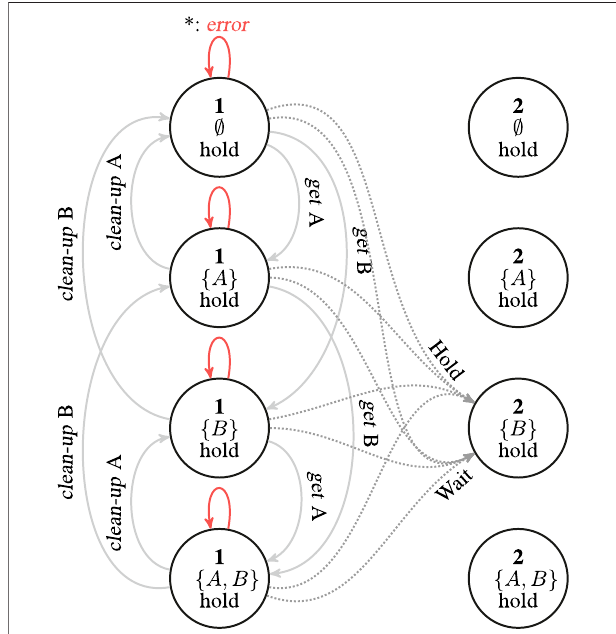
FIGURE 2 | Simpli fi ed representation of the restricted model (RM) used in this work. The fi gure represents an RM associated with a subtask 1 whose successorintheHTMissubtask 2 .Thiscouldbeanyoftheterminatingnodes in Figure 1 that are connected via a sequential operator; please refer to Section 3.3 to understand how to connect RMs with the alternative and parallel operators).Forthesakeofsimplicity,the fi gureonlyrepresentsactions that are taken starting from subtask 1 . We assume that only two objects “ A ” and “ B ” are available and that “ A ” is consumed by the subtask (like a part of the assembly would be) while “ B ” is a tool used during the task (e.g., a screwdriver). Each node represents a state, that is a factorization of the HTM subtask, each possible combination of objects on the workspace, and the user preference regarding the hold supportive action. Full connections in the graph represent successful transitions for theactions get and clean-up appliedtoobjects “ A ” and “ B ” (thatleadtoa none observation). When taken from other states (e.g., bringing “ A ” which is already on the workspace), the action would fail, with an error observation, and the state would not change. These cases are represented by the red connections. Finally, the dotted connections represent the hold and wait actions that, from any of the represented states, lead to a transition to the state of the next subtask for which object “ B ” only is present (i.e., the tool). This means that the transition occurseveniftherobotfailedtobringalltherequiredtoolsandparts: we assume here that the human would be able compensate for robot failures. The reward would however be maximal in the transition from state with { A , B }. To simplify the fi gure, we omitted the states corresponding to the no-hold preference. The graph for the no-hold preference is nearly identical except for the fact that the hold action fails from these states and hence wait is the only action to transition to the next